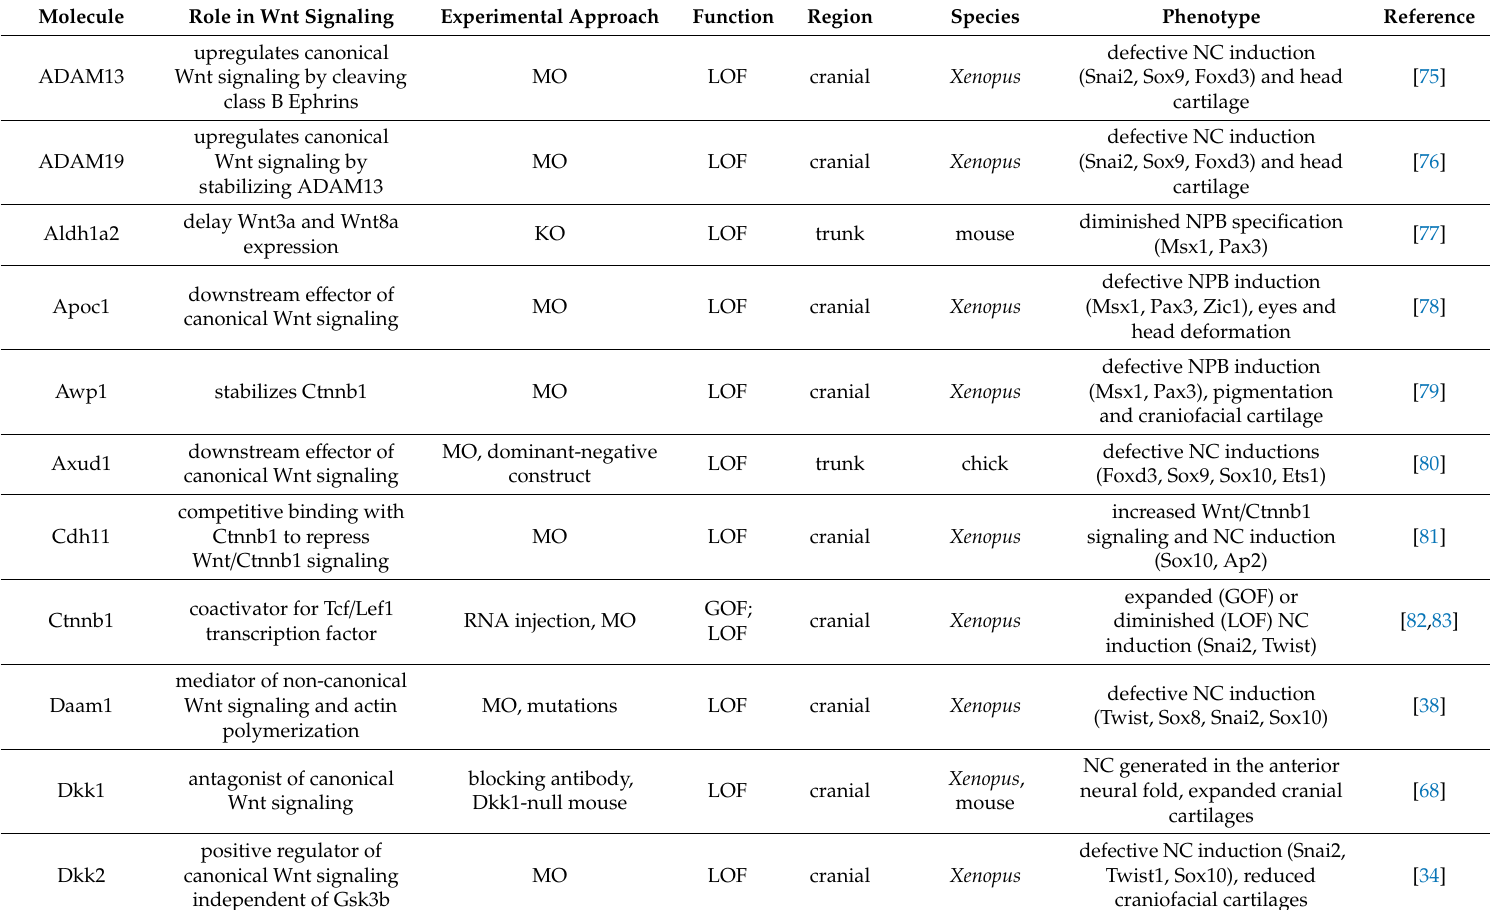
Table 1. Experimental findings of Wnt signaling molecules, modulators, and e ff ectors in vertebrate neural crest induction and specification. (cKO, conditional knockout; GOF, gain of function; KO, knockout; LOF, loss of function; MO; morpholino).